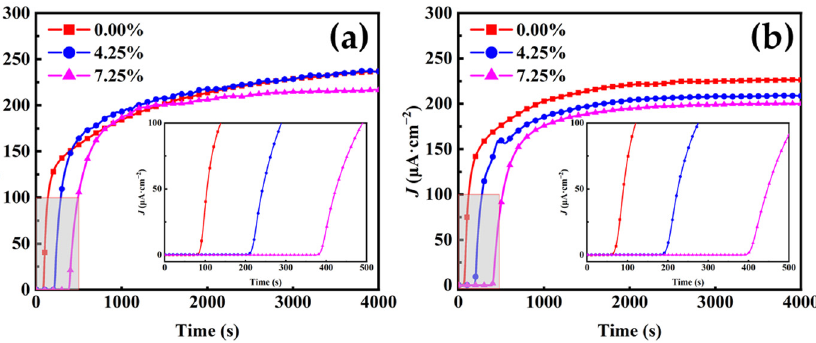
Figure 4. Hydrogen permeation curves of X65 steel with different cold deformation levels: ( a ) the first hydrogen permeation curves, ( b ) the second hydrogen permeation curves.